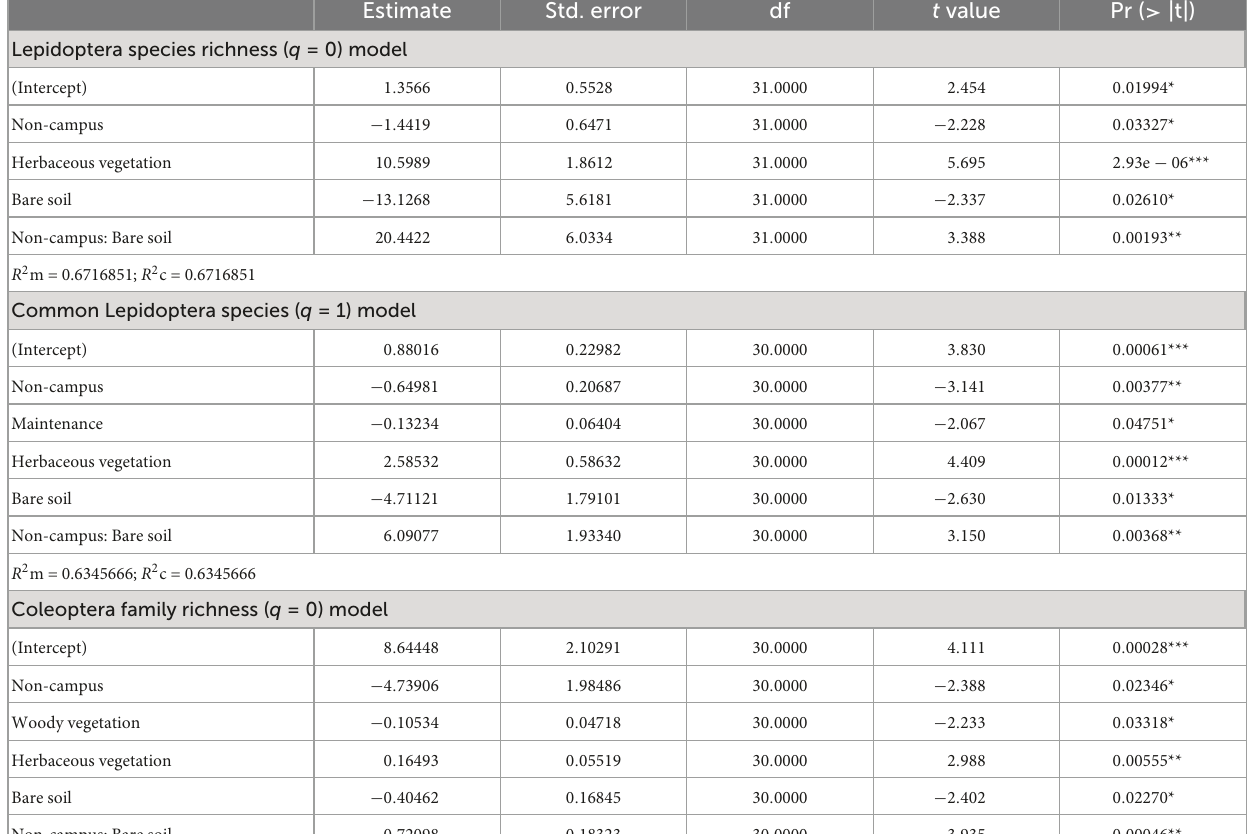
TABLE 1 Generalized linear mixed models (GLMMs) for species richness ( q = 0) and the common species ( q = 1) diversity index. Estimate Std. error df t value Pr ( >